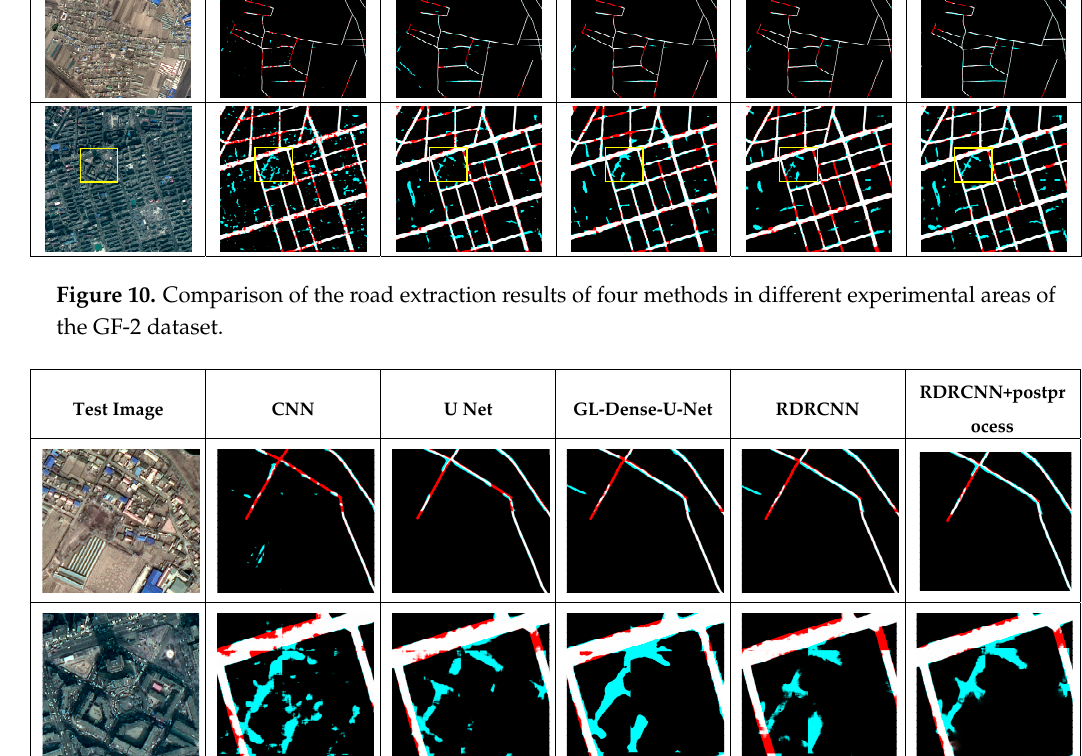
Figure 11. Comparison of road extraction results among different algorithms in local areas (the small area in the yellow rectangular frame from the image in Figure 10). Table 7. The statistics of the accuracy of the extracted results in Figure 10 with different methods.